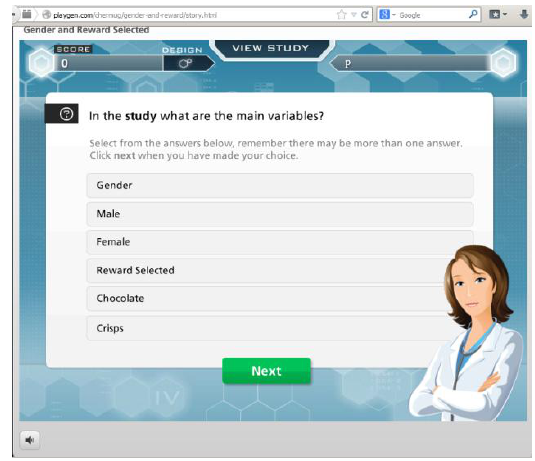
Figure 1. An example of identifying the main variables of a